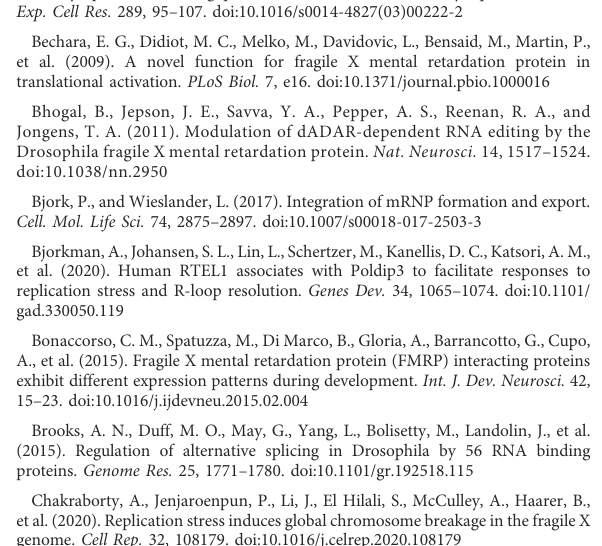
EnrichmentanalysisofthePND14ratforebrainnuclearproteome.Details for enrichment analysis of the nuclear protein dataset against Rattus norvegicus proteome. for GO Cellular Component, GO Molecular Function terms or GO Biological Process terms and REACTOME pathways using the DAVID